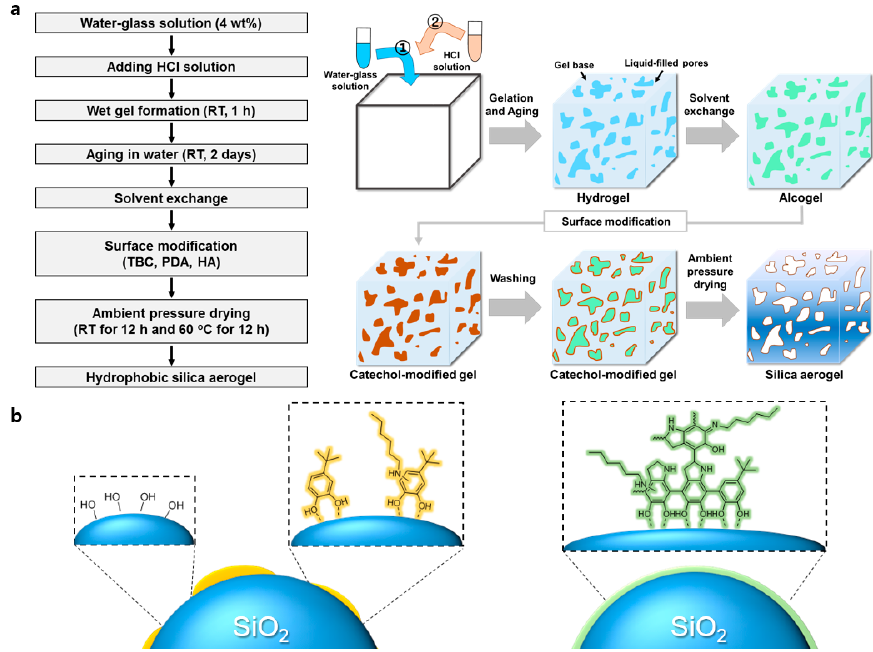
Figure 1. Schematic of ( a ) the synthesis process of catechol-modified water-glass-based silica aerogel, and ( b ) the proposed surface structure of 4- tert -butylcatechol (TBC) + hexylamine (HA) case (left) and polydopamine (PDA) + TBC + HA case